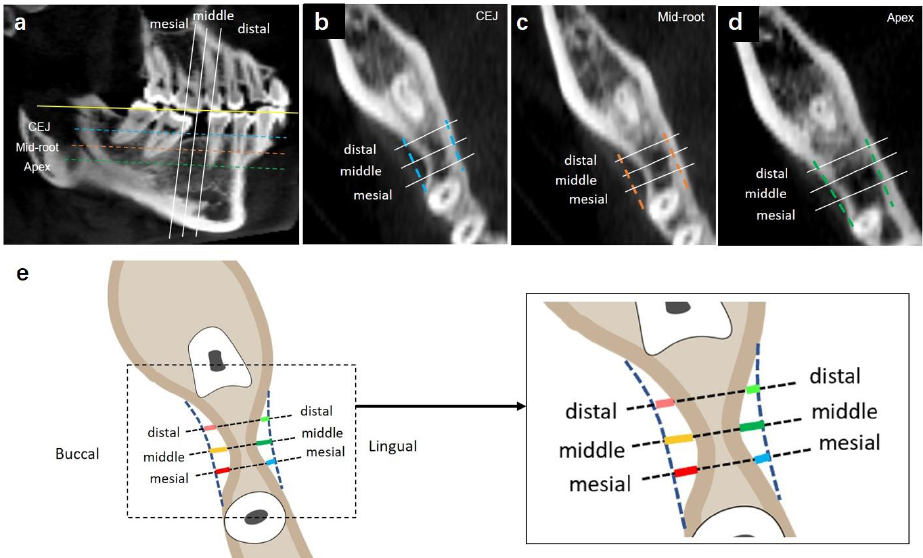
Figure 3. ( a ) Horizontal alveolar bone levels of the missing mandibular first molar. ( b ) Measurements at the CEJ level. ( c ) Measurements at the mid-root level. ( d ) Measurements at the apex level. ( e ) Illustration showing the measurements of 6 sites at three levels. A total of 6 sites (buccal: mesial, middle, distal; lingual: mesial, middle, distal) in each of the three sections (CEJ, mid-root, and apex) were taken. The line drawn perpendicular to the original bone cortex from the 6 sites was measured as the horizontal resorption of the alveolar bone.